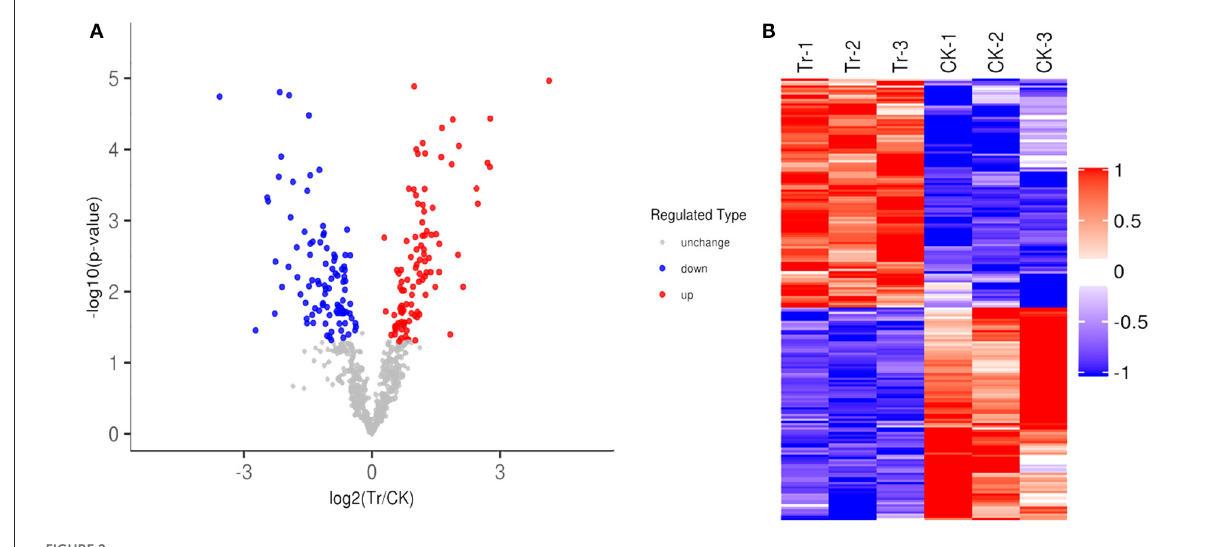
FIGURE2 Volcano (A) and heatmap (B) of differently expressed acetylated proteins.